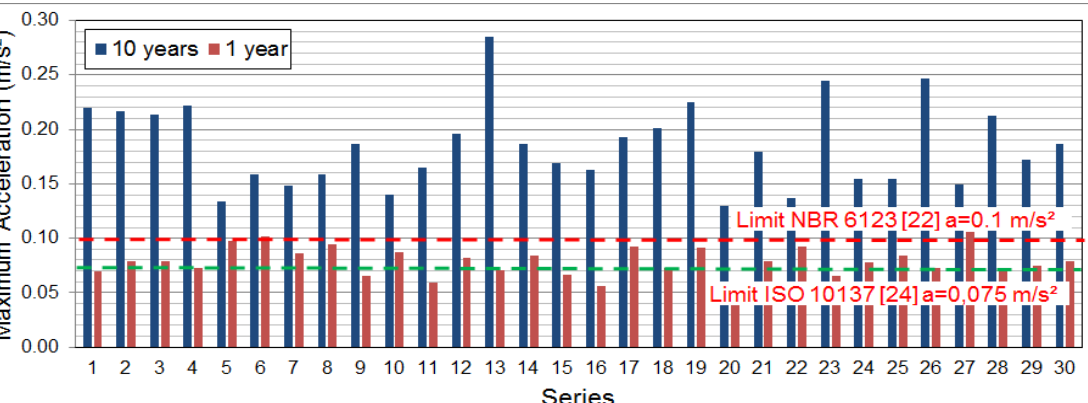
Figure 16. Maximum accelerations values obtained for each nondeterministic wind series considering a period of recurrence of 10 years and 1